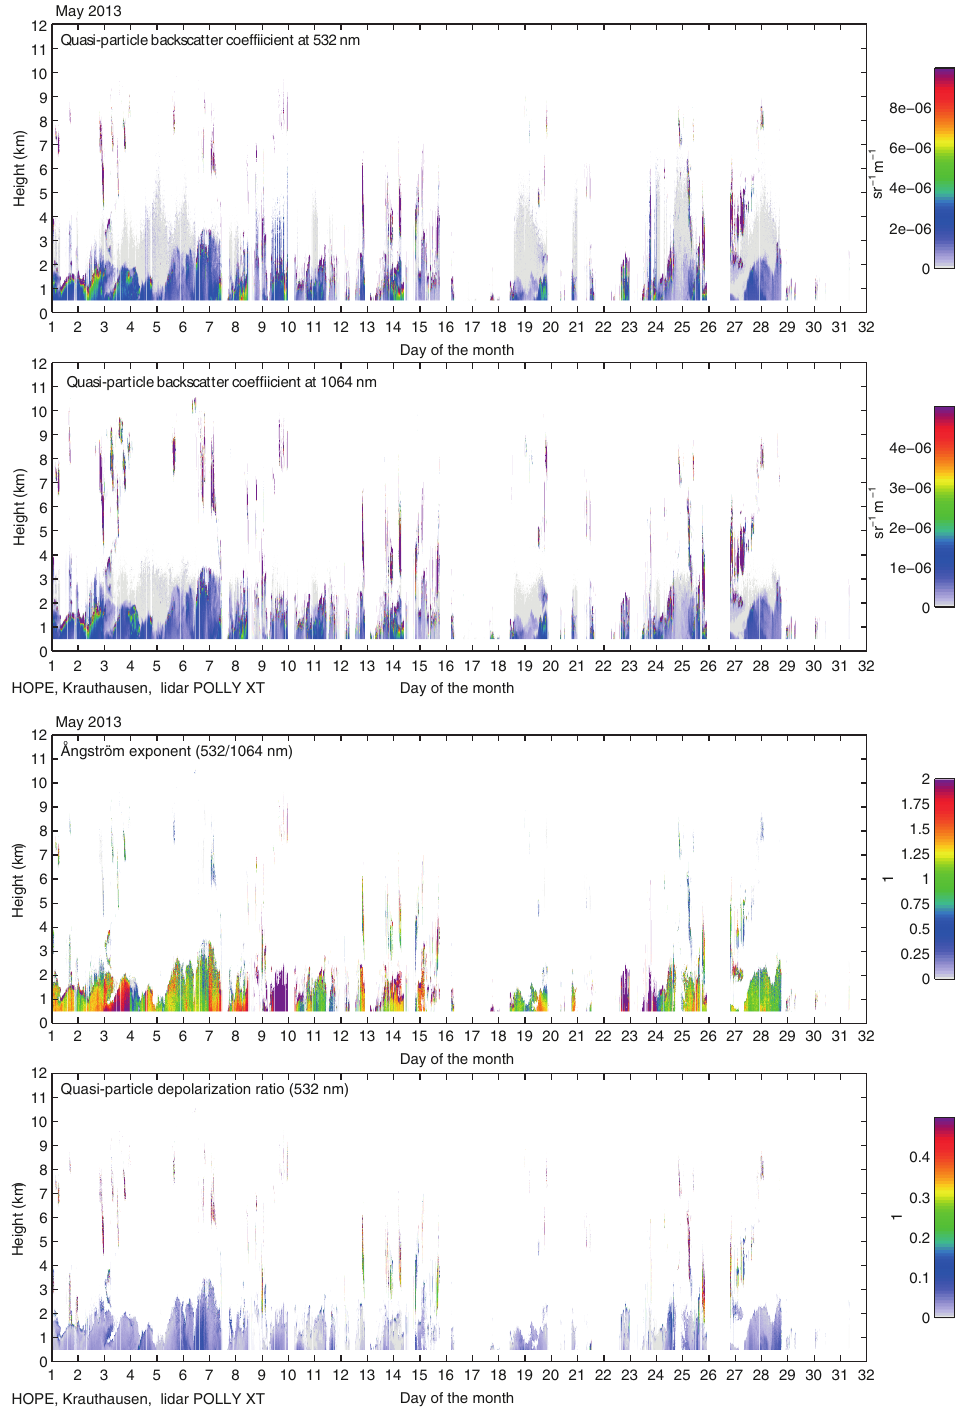
Figure A2. Overview of MWL Polly XT observations in May 2013. Top to bottom: quasi-particle-backscatter coefficient at 532 and 1064nm, corresponding Ångström exponent, and quasi-particle de- polarization ratio at